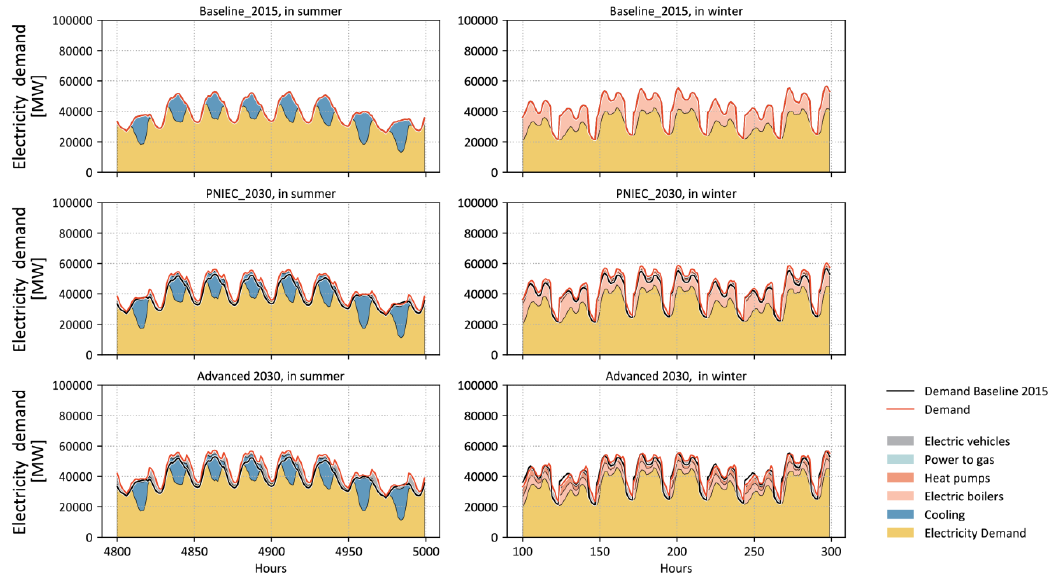
Figure 8. Hourly electricity demand: different contributions for two weeks of the year (one in summer and one in winter) for the scenarios Baseline 2015, PNIEC 2030 and Advanced 2030.